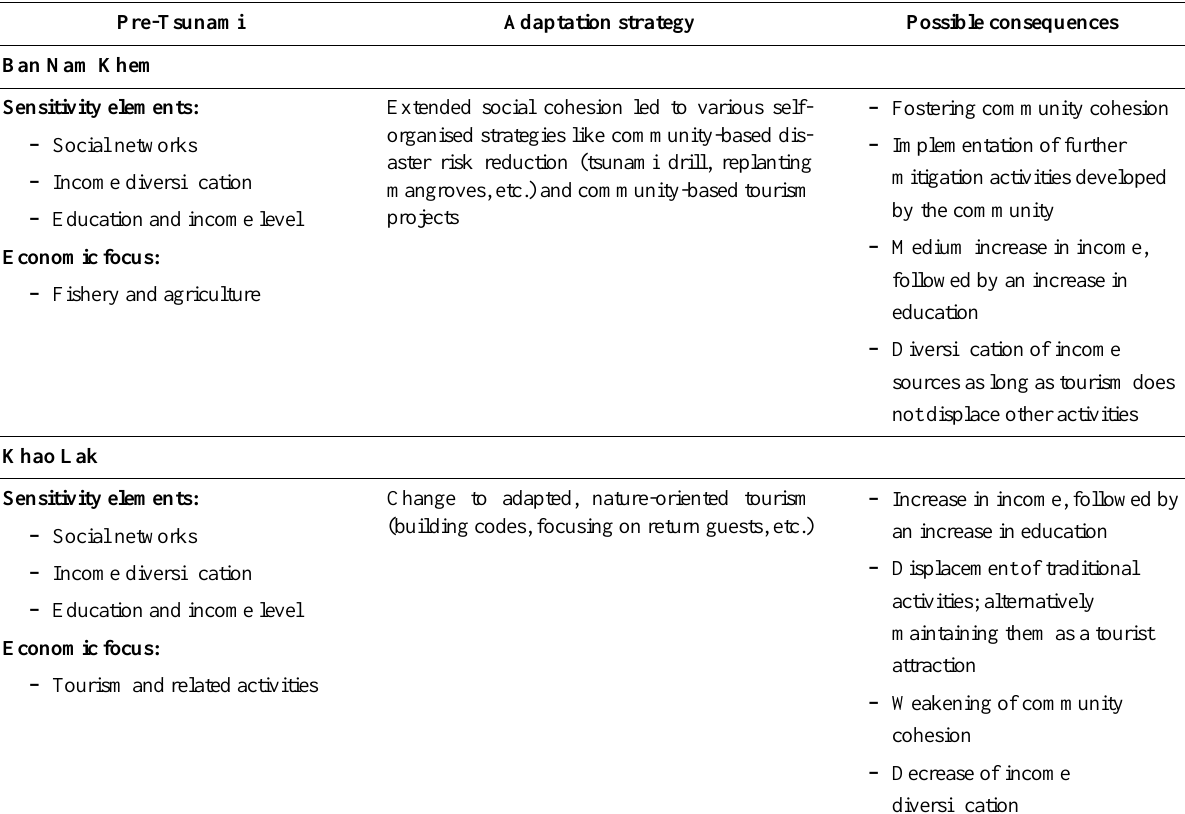
Table 2. Adaptation strategies: the influence of sensitivity elements and possible